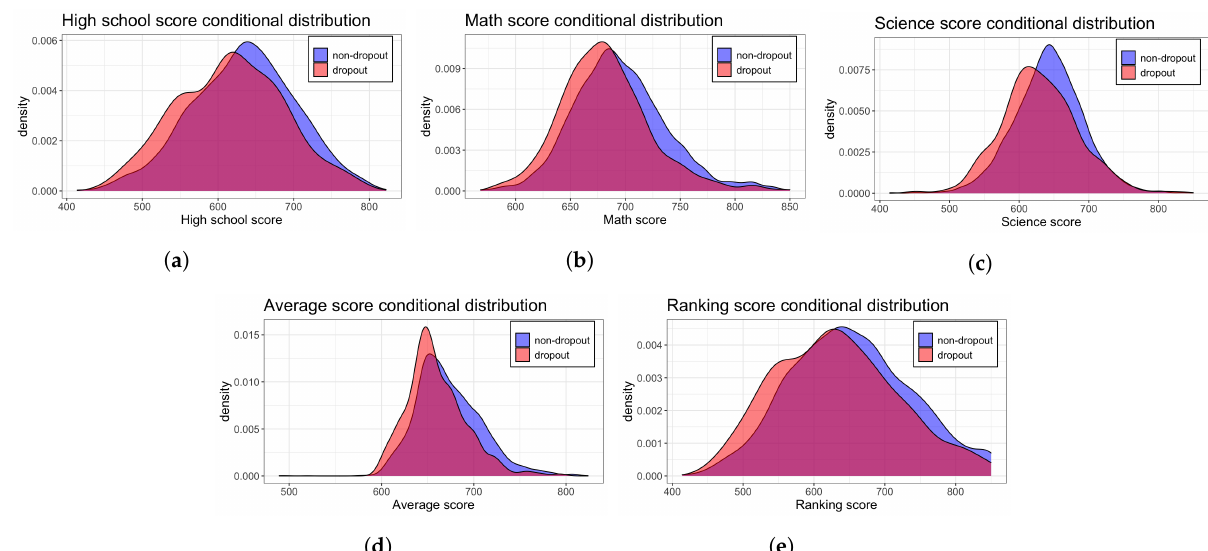
Figure 1. Score conditional distributions based on the DROPOUT variable, with respect to each variable within the Universidad Adolfo Ibáñez dataset. ( a ) Variable nem. ( b ) Variable mat. ( c ) Variable optional. ( d ) Variable pps. ( e ) Variable